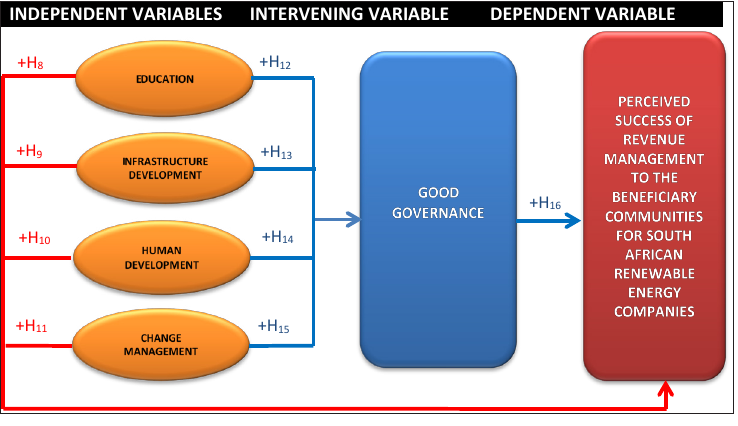
Figure 1: Proposed theoretical Sub-model – Transformational